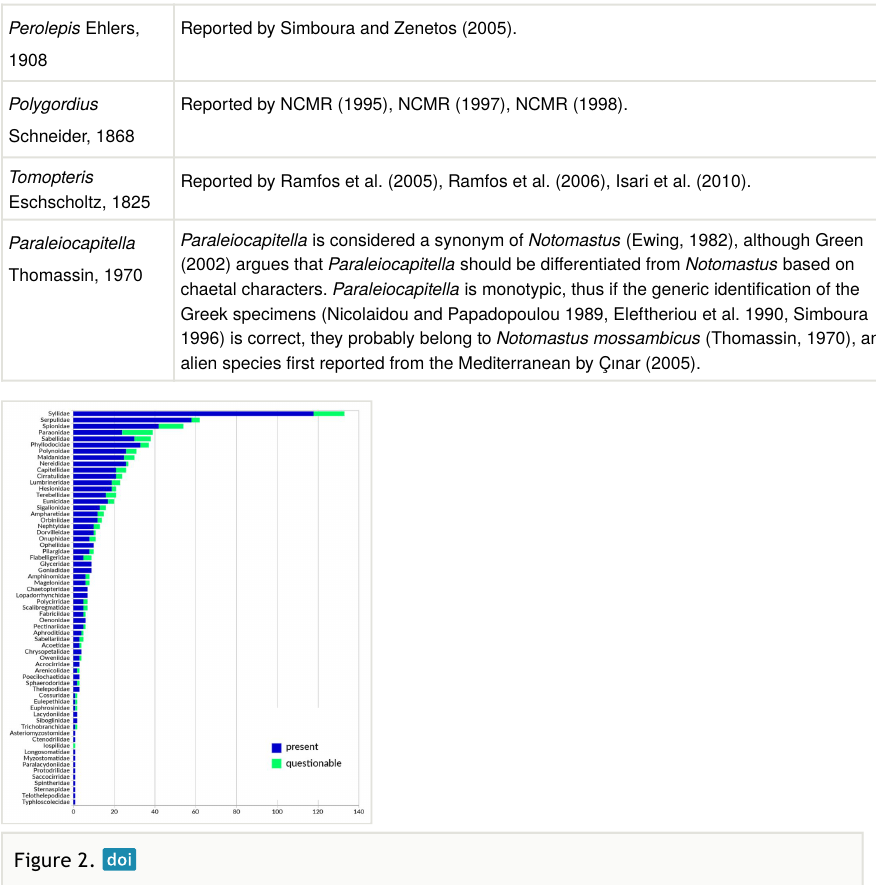
Numbers of polychaete species per family in Greece and their status (present /